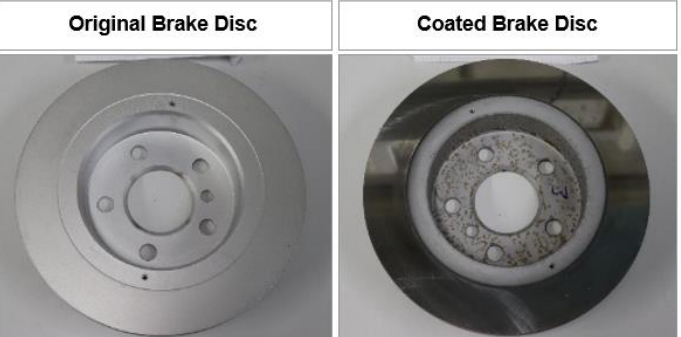
Figure 6. Original cast-iron brake disc and the brake disc with a hard coating. The discs were coated by ARS Autoteile GmbH (now FRENOZA GmbH).